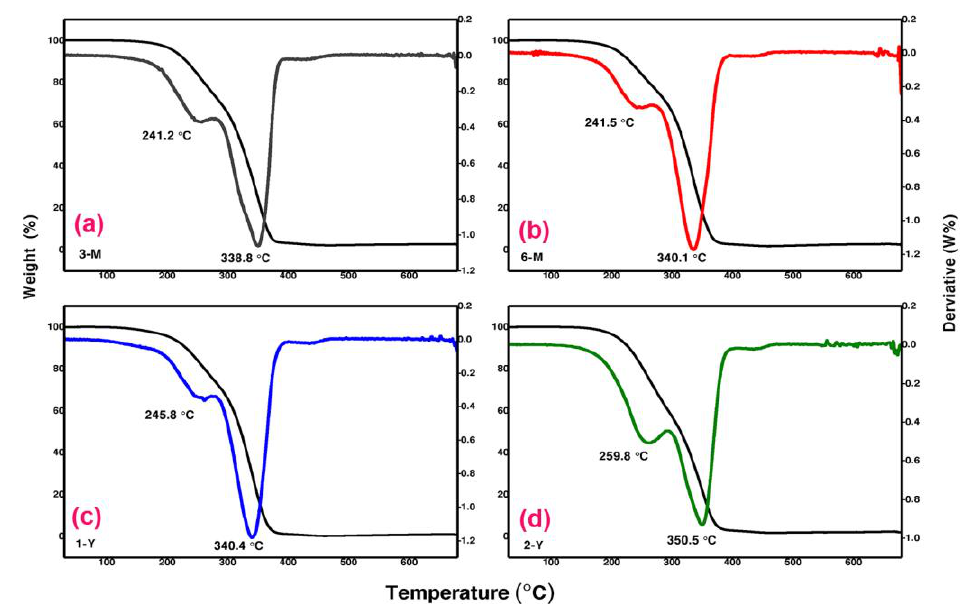
Figure 5. Thermogravimetric curves and their derivatives from room temperature to 700 °C for BW samples at different storage times: ( a ) 3-M aged three months, ( b ) 6-M aged six months, ( c ) 1-Y aged one year, and ( d ) 2-Y aged two years. The thin black lines represent weight loss curves, while the colored lines represent weight loss derivatives.